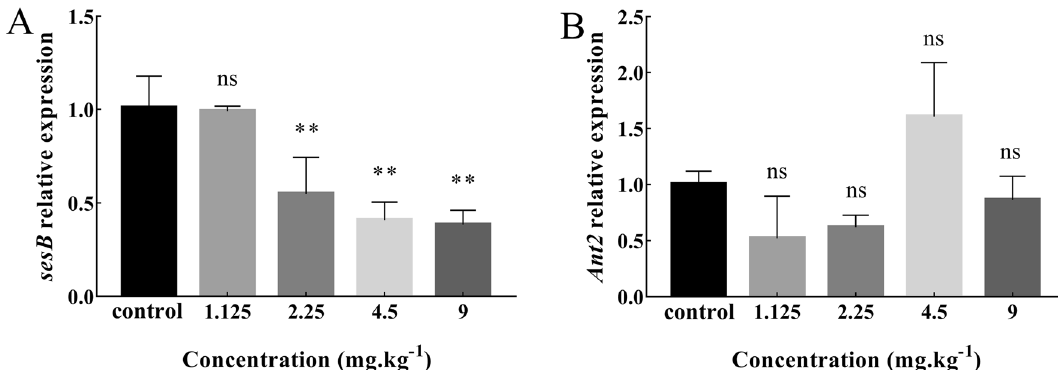
Figure 6. Effects of Cd on the gene expression of adenine nucleotide transferase coding genes sesB ( A ) and Ant2 ( B ) in Drosophila third instar larvae (Mean ± SD, n = 3, 6 larvae per sample, ** P < 0.01, ns = not significant). The mRNA expression of sesB in treatment groups reduced significantly compared with the control group ( P < 0.01). There was no significant difference in mRNA expression level of Ant2 of Cd treatment groups compared with the control group ( P >